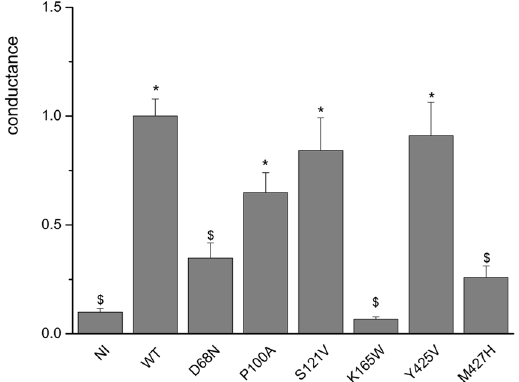
Figure 4. Conductance of ClC-Kb mutants. Conductance at + 60 mV in solution containing 20 mM Ca 2 + at pH 9.0 is normalized to the mean value for wild-type (WT) ClC-Kb. Each column represents the mean ± SEM for the conductance (NI, n = 22; WT, n = 31; D68N, n = 18, P100A, n = 13, S121V, n = 13, K165W, n = 9; Y425V, n = 6; M427H, n = 9). * P < 0.05 is the difference between WT or mutant ClC-Kb vs NI. $ P < 0.05 is the difference between NI or mutant ClC-Kb vs WT